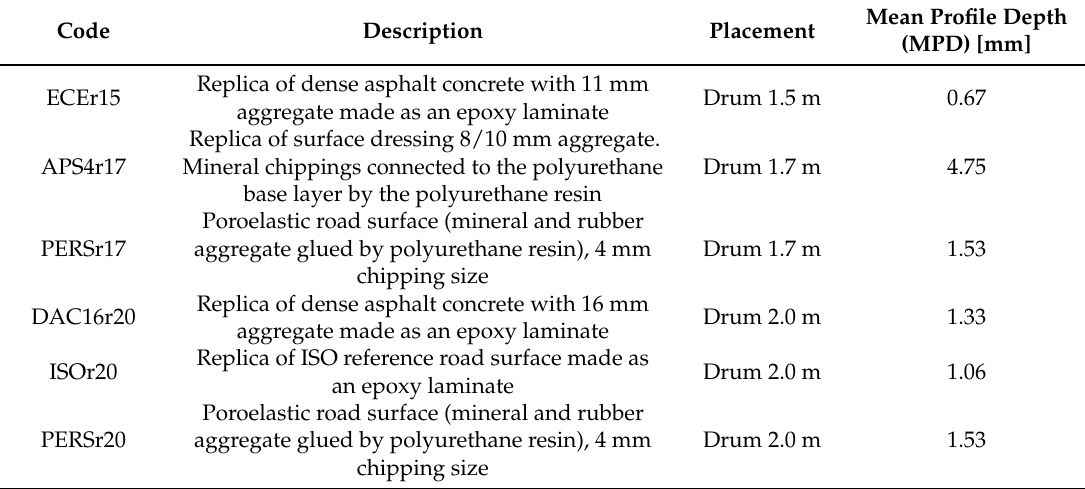
Table 3. Description of replica road surfaces fitted to the